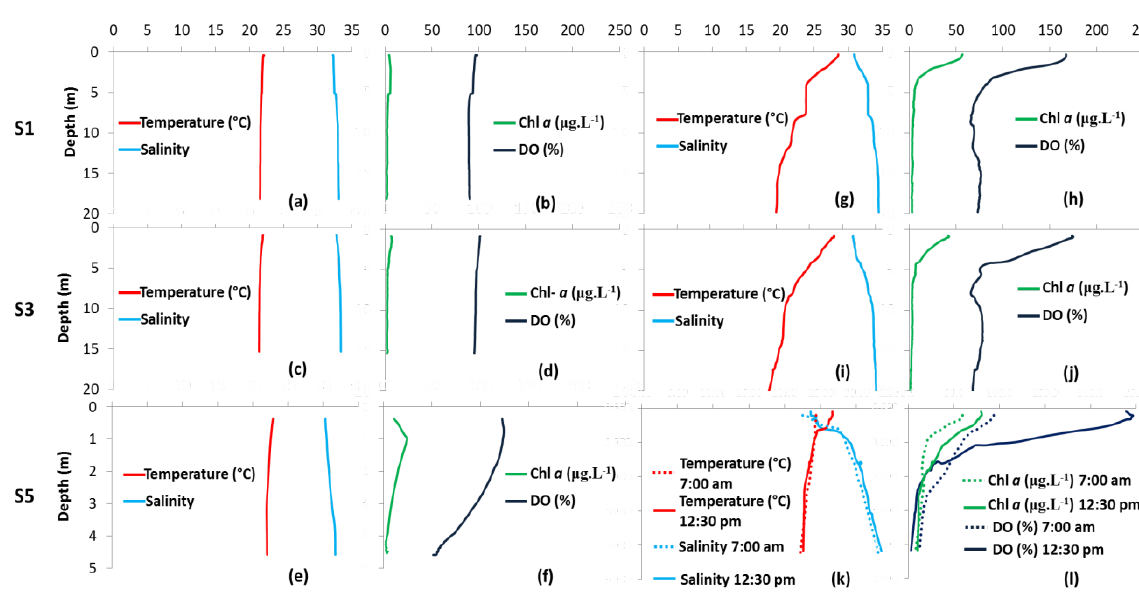
Figure 3. Typical vertical profiles of salinity, temperature, dissolved oxygen (DO) and chlorophyll a (Chl a ) in the water column. Profiles are shown for S1, S3 and S5 in summer and winter conditions. Note the different depth scale for the S5. The dotted line in (k) and (l) shows the night-time profile (07:00), whereas the full line shows a daytime profile (12:30) for the same day at the same